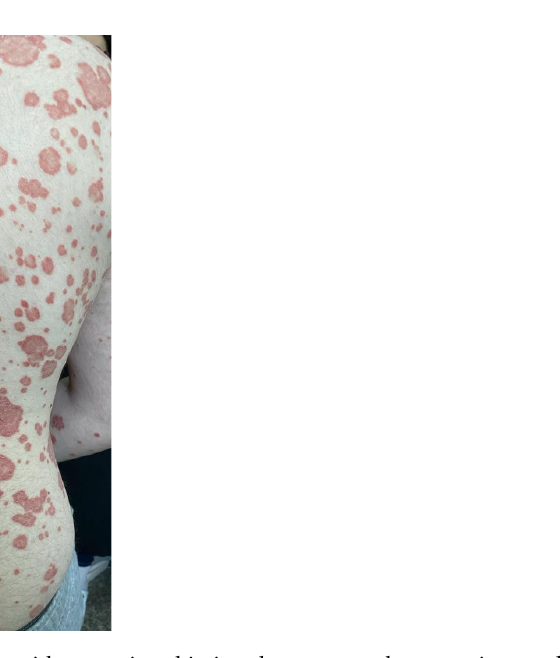
Figure 3. Chronic plaque psoriasis with extensive skin involvement on the posterior trunk and on the upper limbs.